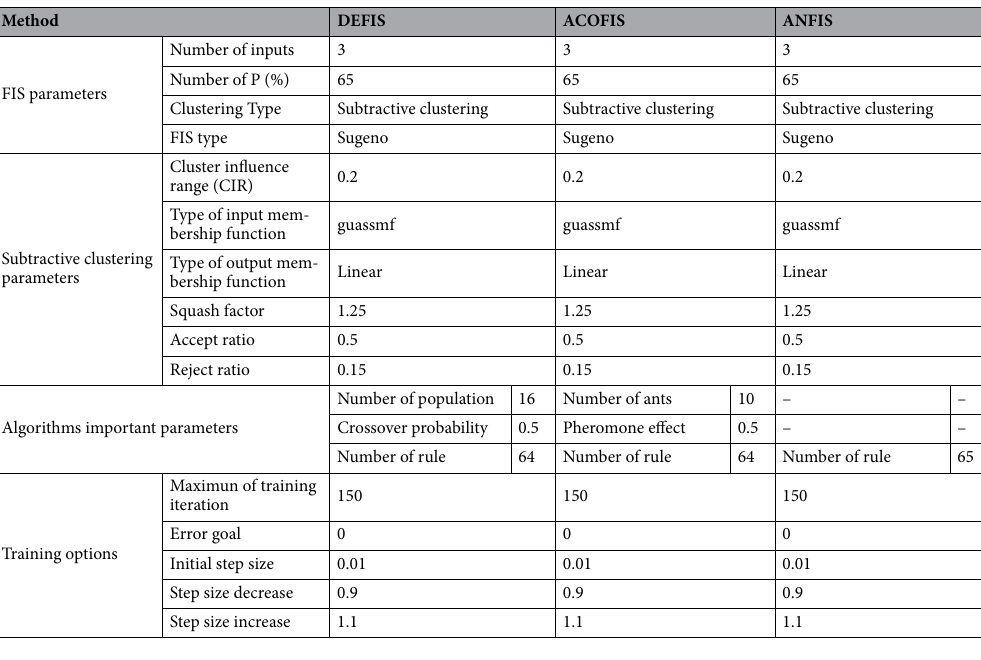
Table 1. DEFIS, ACOFIS, ANFIS set parameters for learning